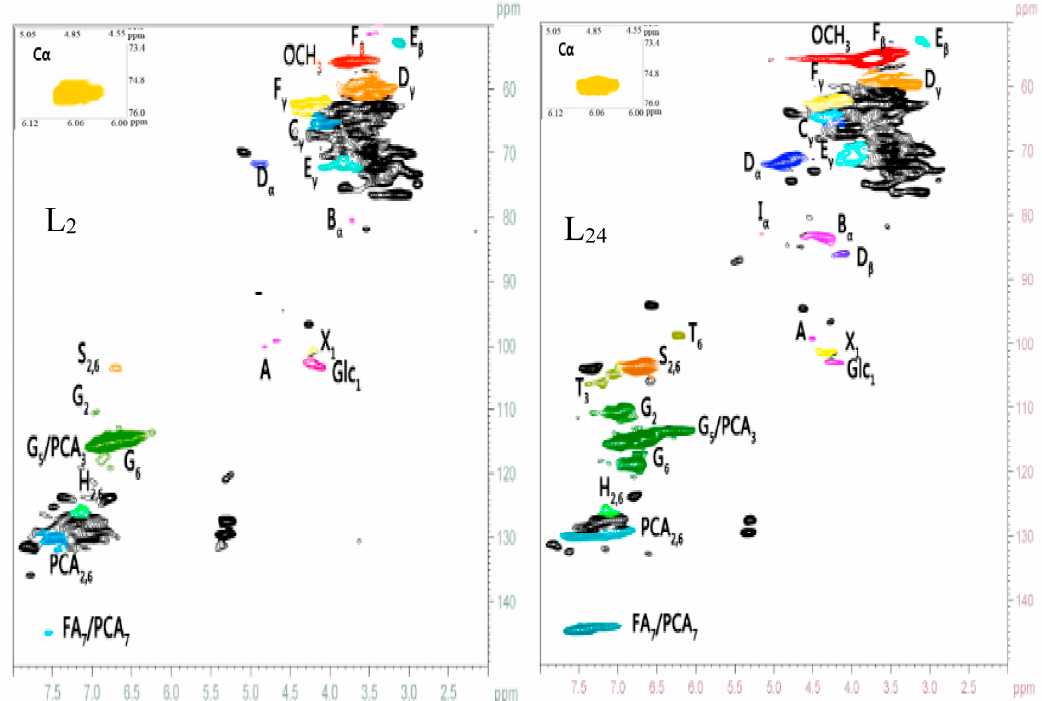
Figure 2. Main classical structures of LCC preparations identified by 2D-HSQC spectra: (A) phenyl glycoside; (B) benzyl ether; (C) ester (C α , α -ester; C γ , γ -ester); (D) β - O -4 substructure; (E) β - β resinol substructure; (F) β -5 phenylcoumaran substructure; (I) β -1 spirodienone substructure; (G) guaiacyl unit; (H) p -hydroxyphenyl unit; (S) syringyl unit; (T) tricin; (PCA) p -coumarate; (FA) ferulic acid unit; (Glc) β - D -glucopyranoside unit (X) β - D -xylopyranoside unit. Different colors represent different structure units.